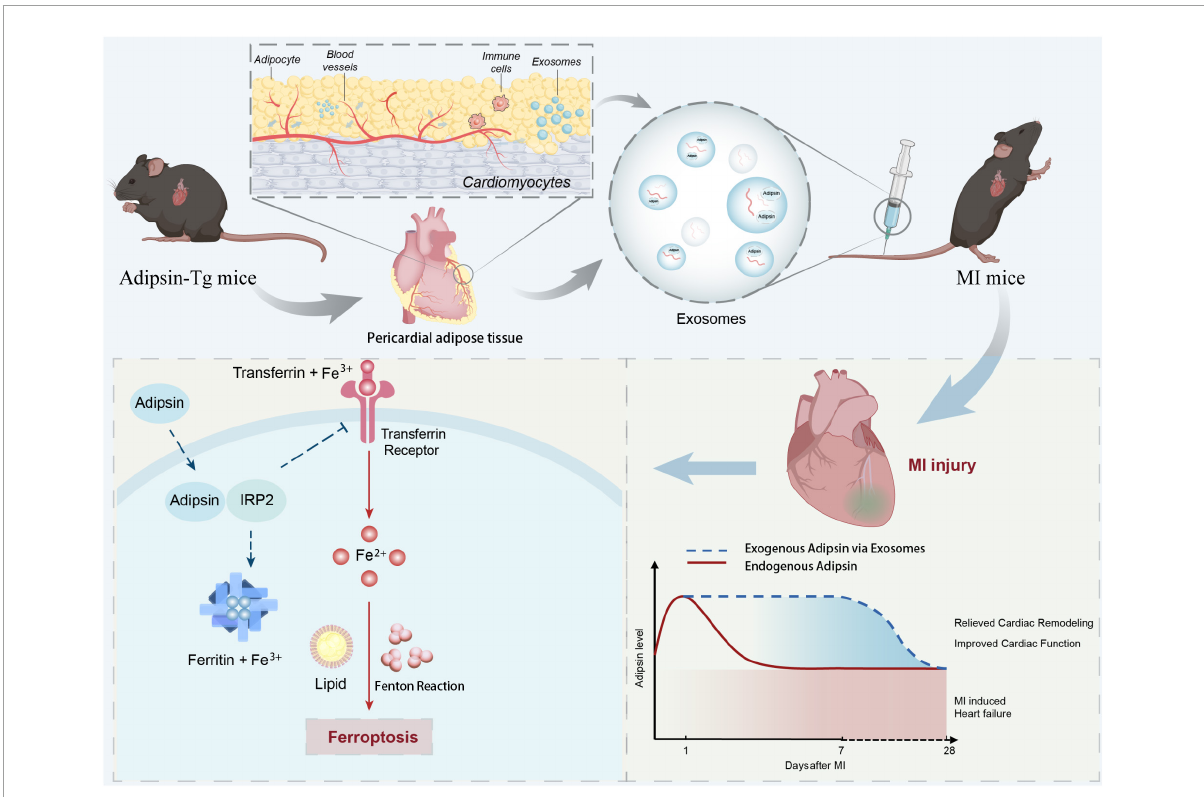
FIGURE8 Schematic diagram. Illustration of time-course of Adipsin levels following MI challenge and the role of exogenous Adipsin-evoked cardioprotection. A reduction of Adipsin expression (red line) is visible during the initial stage of MI. Exogenous administration of Adipsin via exosomes (blue dashed line) triggers cardioprotection, relieves cardiac remodeling, and improves cardiac function. MI, myocardial infarction; IRP2, Iron regulatory protein 2; ROS, reactive oxygen